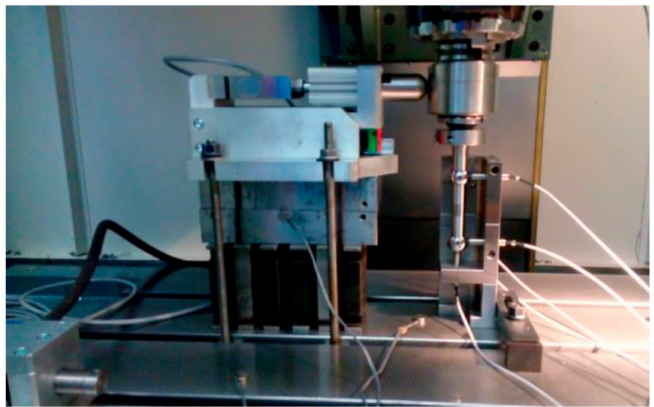
Figure 60. The load unit used on a machine tool